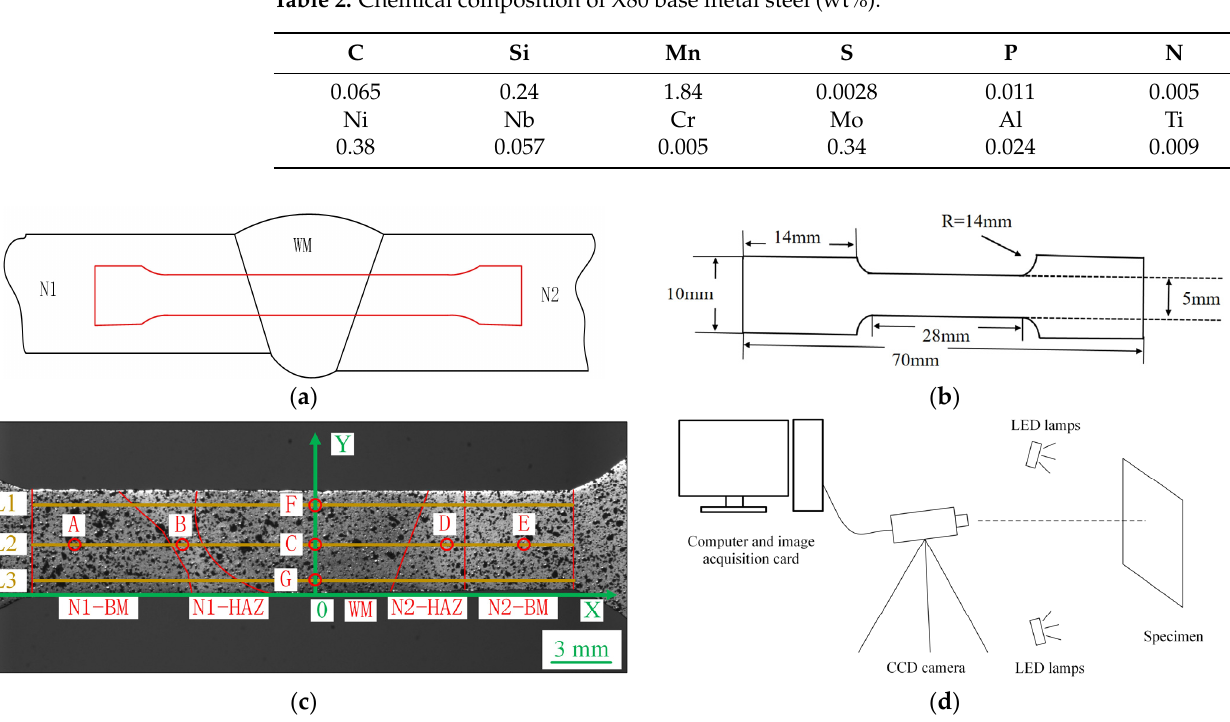
Figure 2. ( a ) Sampling direction; ( b ) sample size; ( c ) zone and mark point locations; ( d ) DIC system schematic diagram. schematic